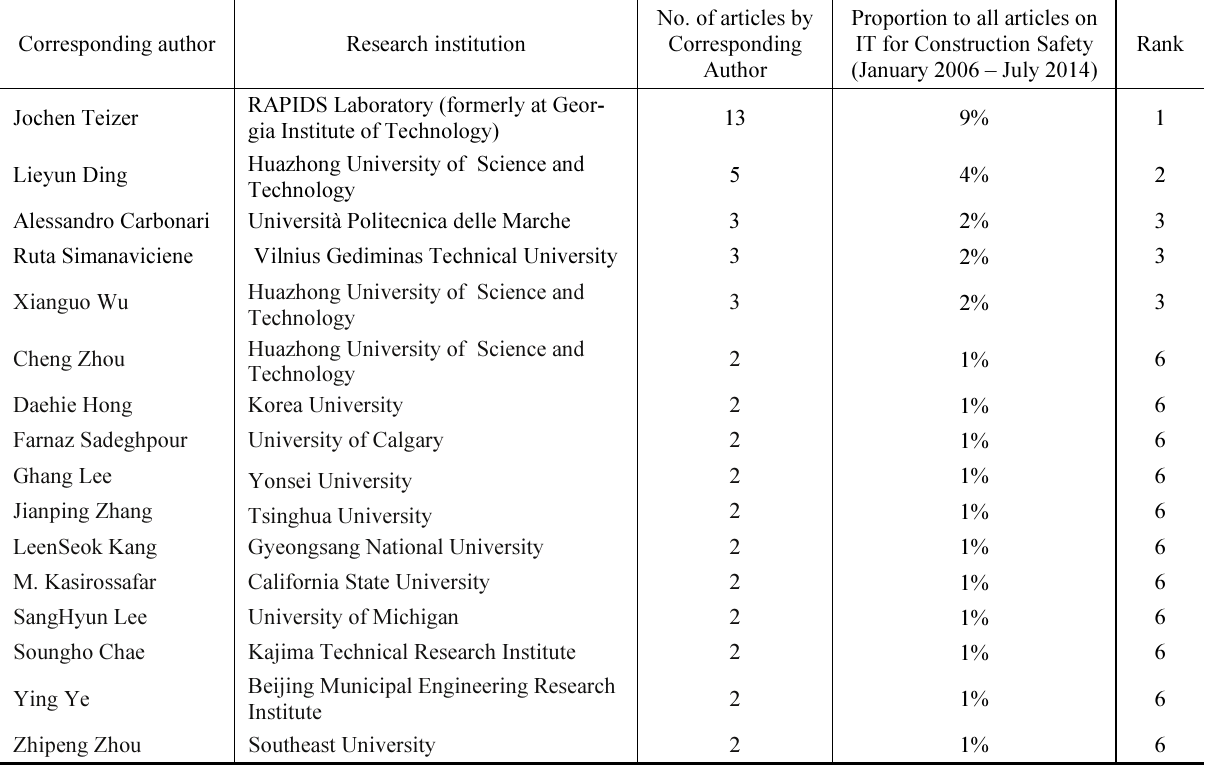
Table 4. Corresponding authors of papers on IT-based construction safety management Corresponding author